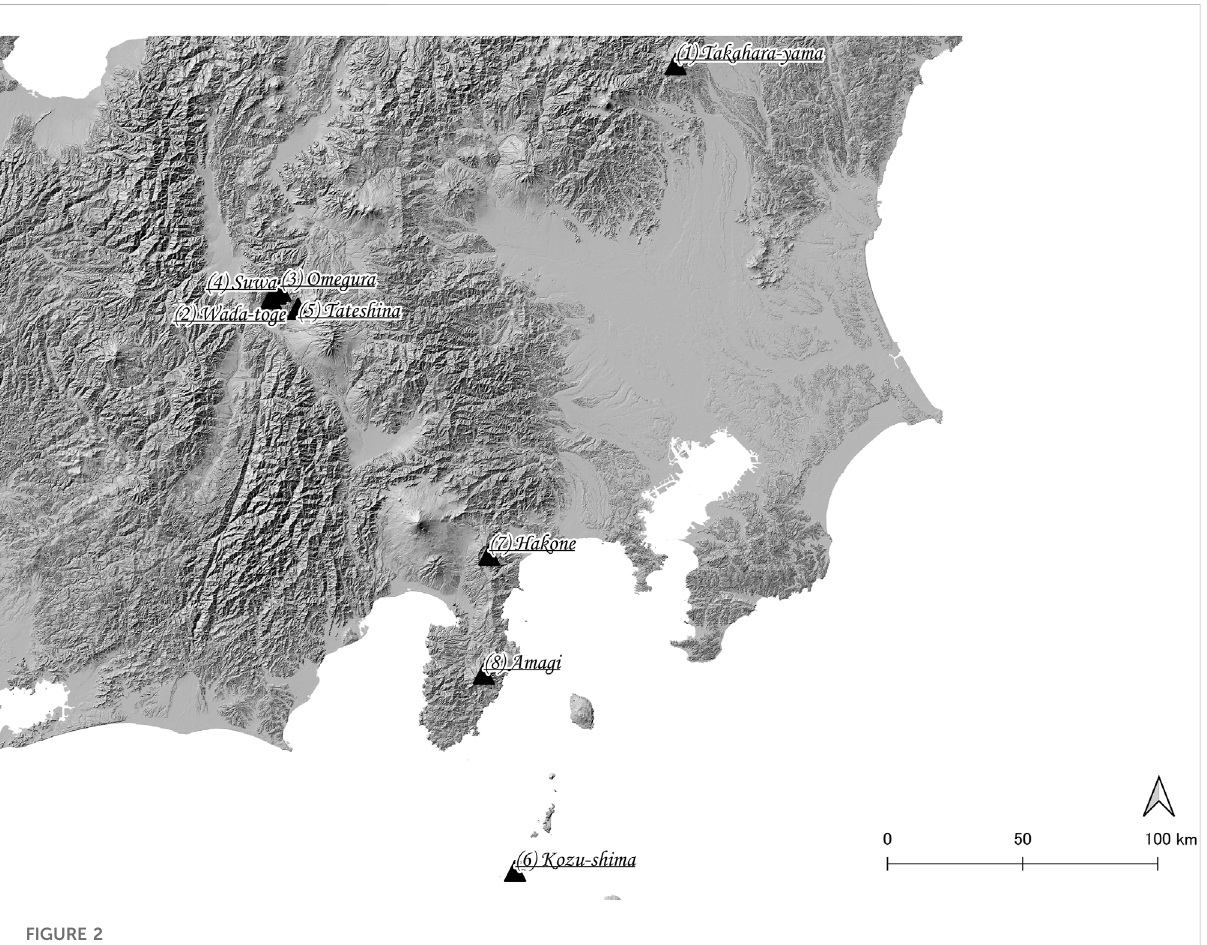
FIGURE 2 Location of major obsidian provenance